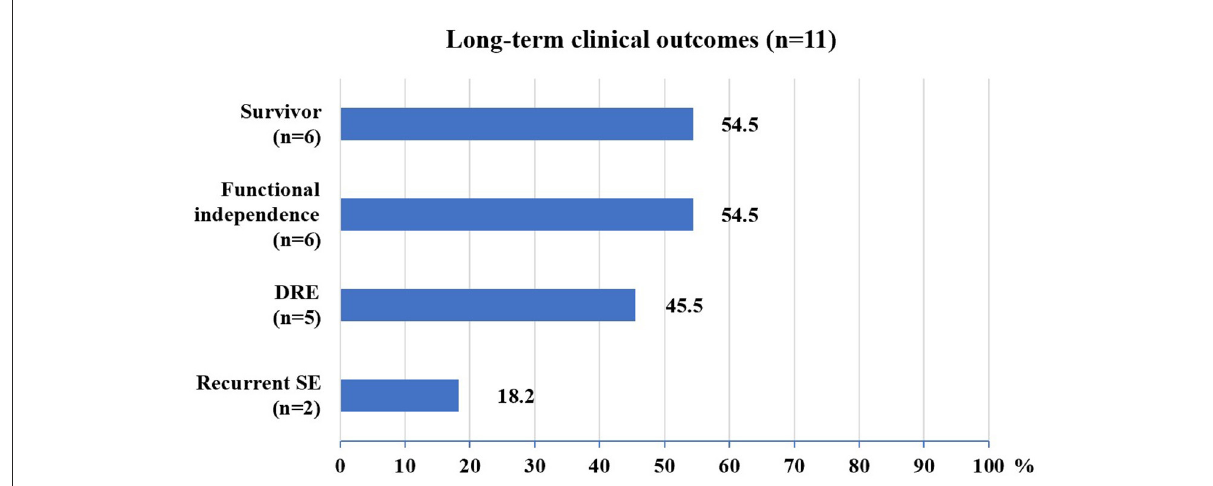
FIGURE2 Long-term clinical outcomes of FIRES patients. DRE, drug-resistant epilepsy; SE, status epilepticus.